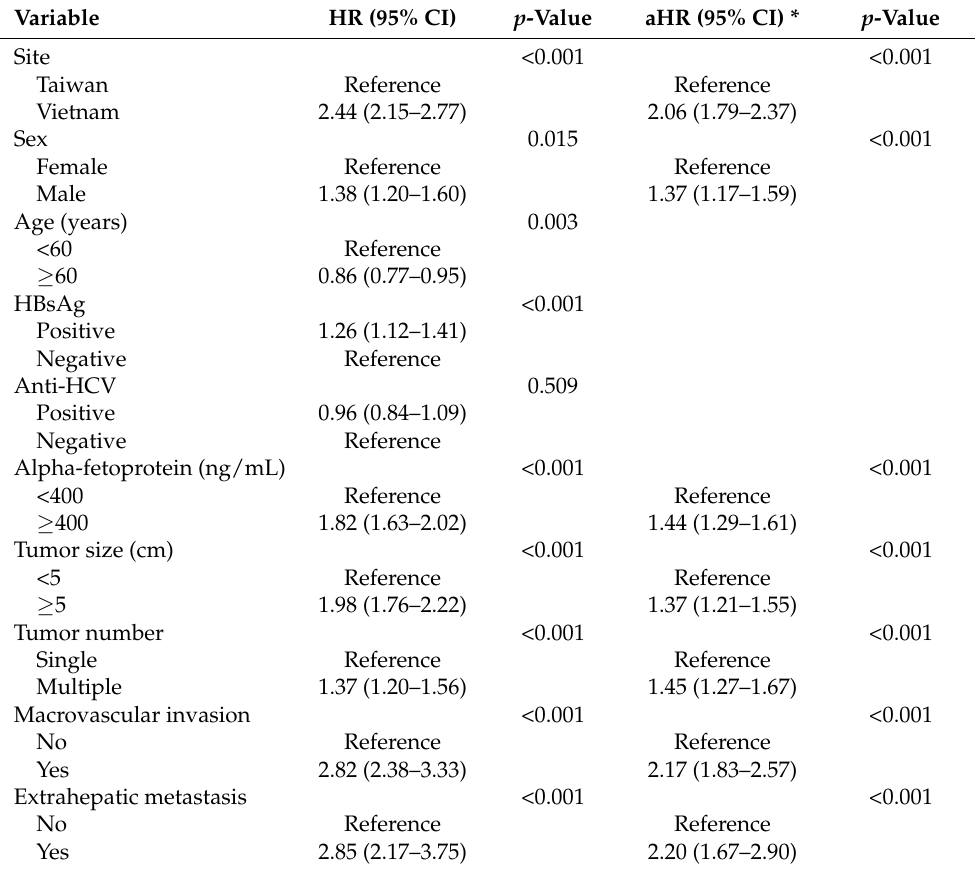
Table 3. Risk of recurrence-free survival for HCC patients receiving hepatic resection.